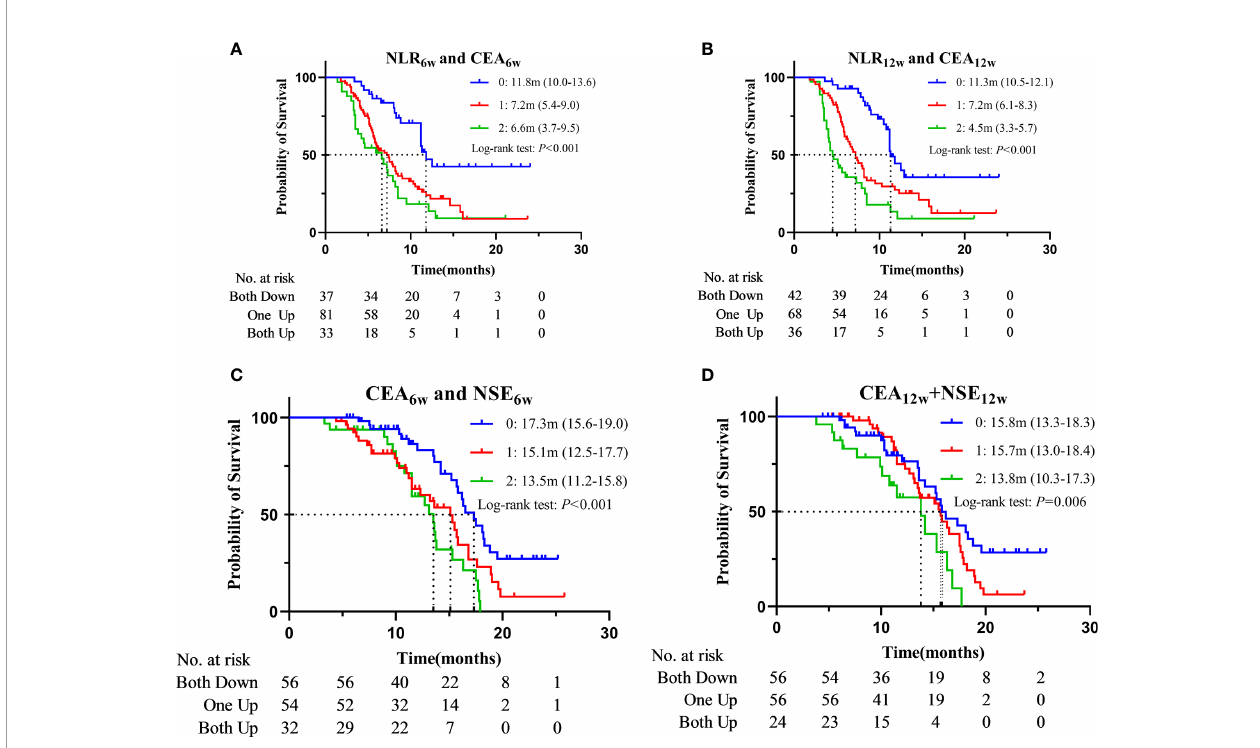
FIGURE 4 | Kaplan – Meier curves for PFS according to “ NLR 6w and CEA 6w ” (A) or “ NLR 12w and CEA 12w ” (B) and for OS according to “ CEA 6w and NSE 6w ” (C) or ” (D) (0: Both Down, 1: One Up, 2: Both “ CEA 12w and NSE 12w